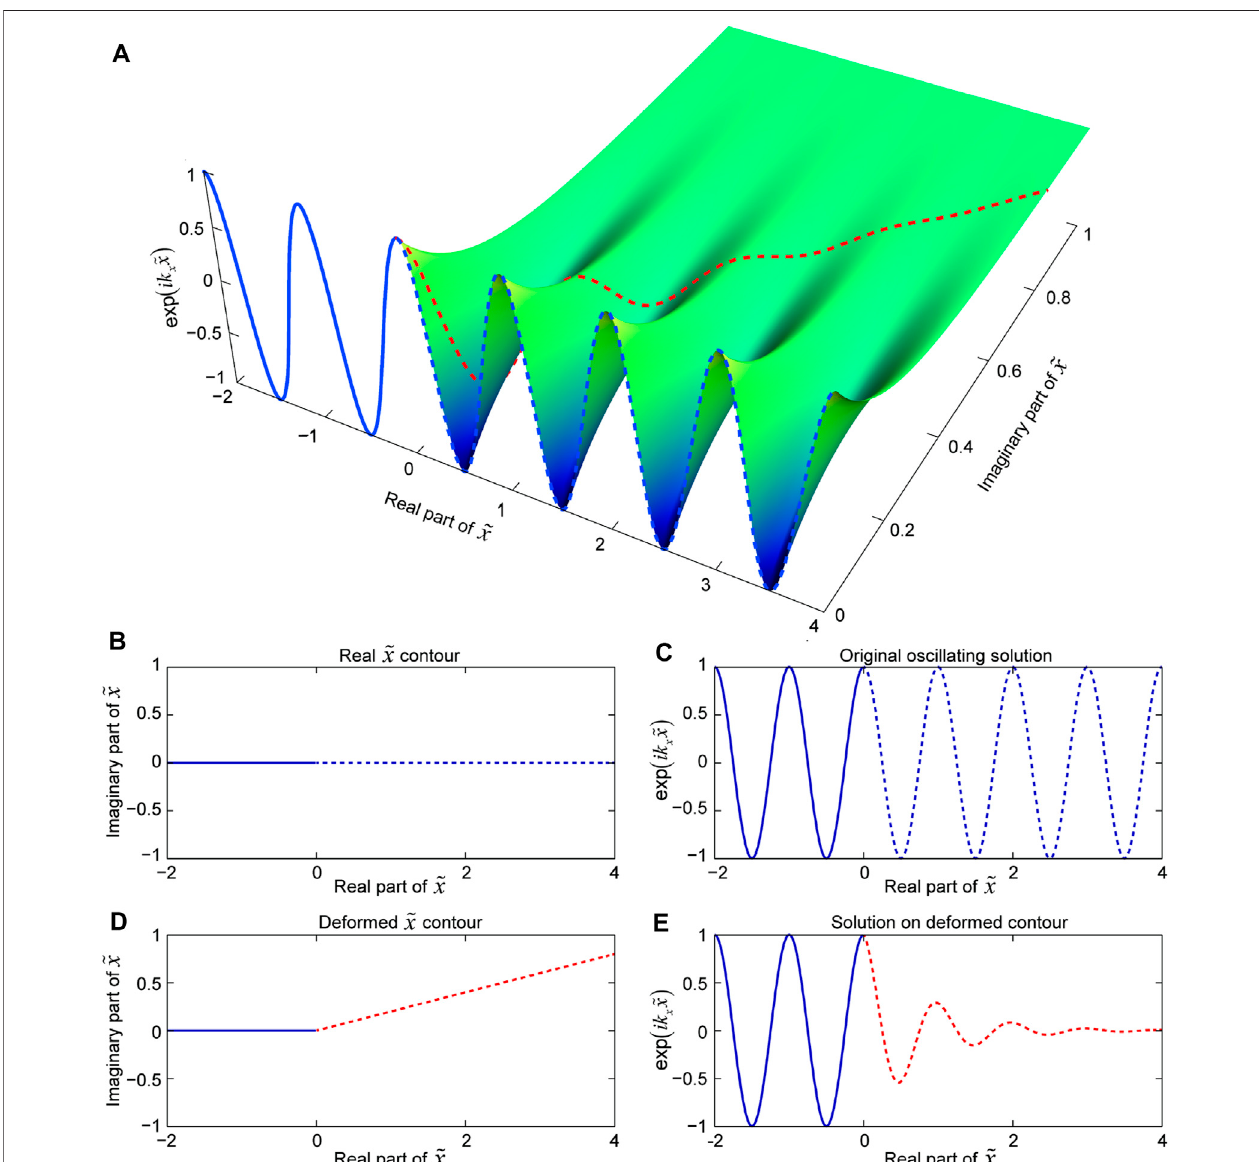
FIGURE 1 | Sketch map of the attenuation principle for the plane waves in the PML region. The coordinate that corresponds to Re ( ~ x ) < 0 represents the normal wave propagation region and no attenuation considered, and the region that corresponds to Re ( ~ x ) > 0 represents the PML region. (A) The attenuation process of the plane waves along different stretching directions in the PML region. (B) The direction along the real axis in the complex coordinate (the dashed blue line in (A) . (C) Real part of oscillating solution exp ( ik x ~ x ) that corresponds to the stretching direction in (B) . (D) The stretching direction along a deformed contour in the complex coordinate (the dashed red line in (A) ). (E) Real part of oscillating solution exp ( ik x ~ x ) that corresponds to the stretching direction in (D) .